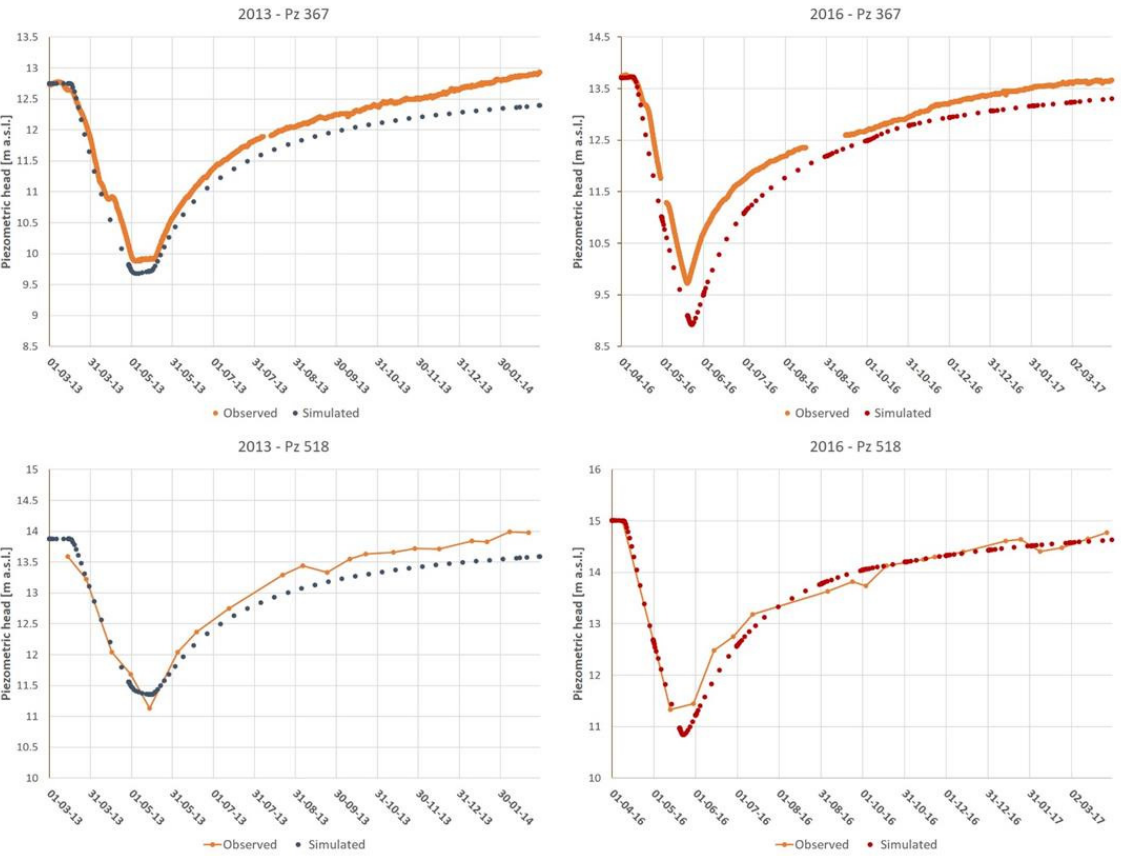
Figure 4. Observed and simulated hydraulic heads in Pz 367 and Pz 518 in 2013 ( left ) and 2016 ( right ). The hydraulic conductivity values obtained in the five upper layers are ranging between 2 × 10 − 6 and 3 × 10 − 5 m/s and the specific storage coefficient values are ranging between 1 × 10 − 5 and 5 × 10 − 4 /m (Figure 5). With such parameter values, the obtained simulated piezometric heads were the closest to the observed